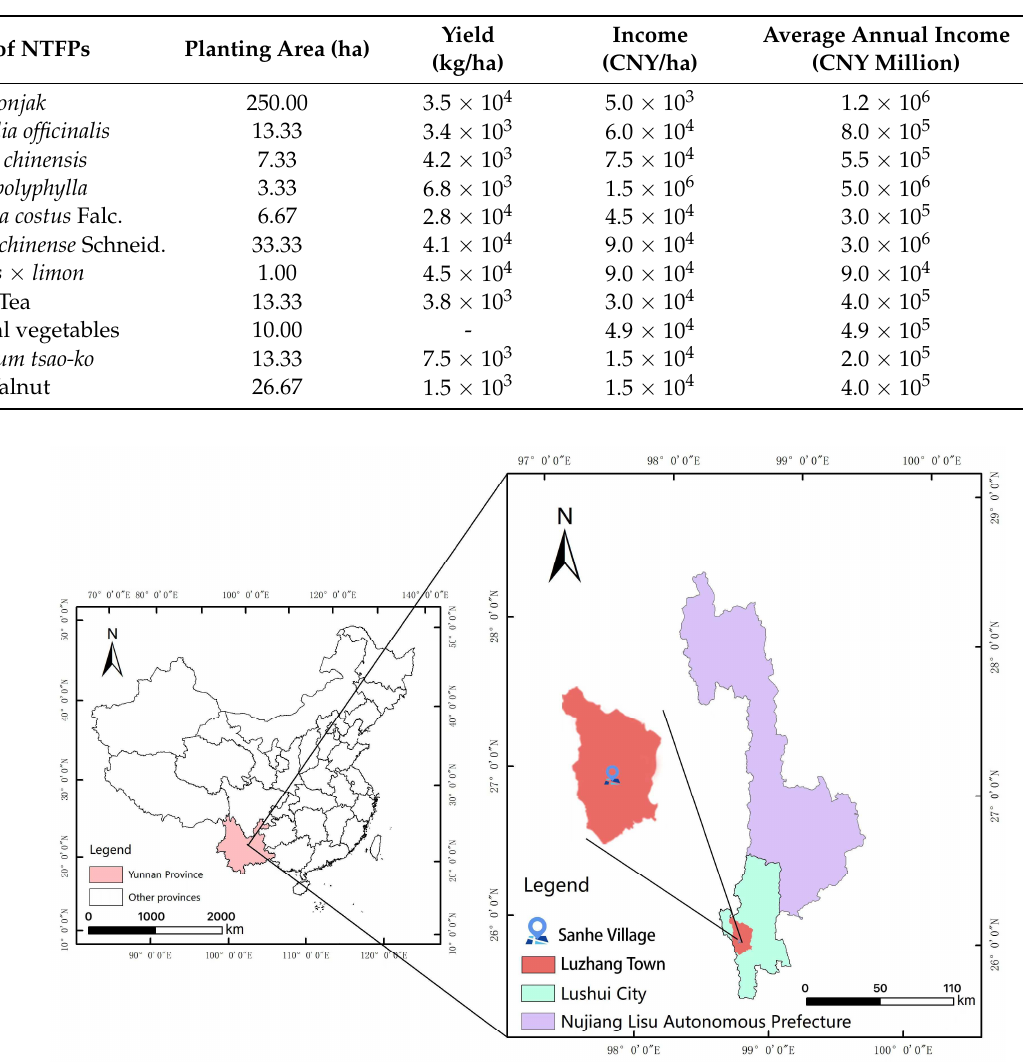
Table 1. The planting areas of and income from the NTFPs industry in Sanhe Village.